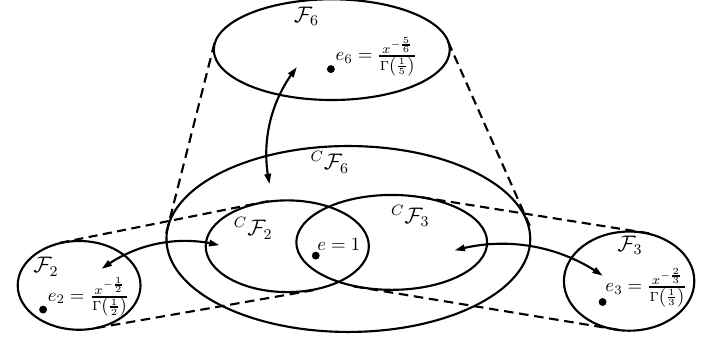
Figure 2. An example of the relationship between Caputo and Riemann-Liouville algebras of orders n = 2 , 3 , 6. Caputo algebras C F 2 , C F 3 are subalgebras of C F . Riemann-Liouville fractional power series sets satisfy F 2 , F 3 ⊂ F 6 , but Riemann-Liouville algebras F 2 , F 3 are not subalgebras of F 6 due to the fact that the product operation ∗ n depends on algebra order. e denotes the unit element of all considered Caputo algebras; e 2 ,e 3 ,e 6 denote unit elements of Riemann-Liouville algebras that correspond to respective fractional differentiation